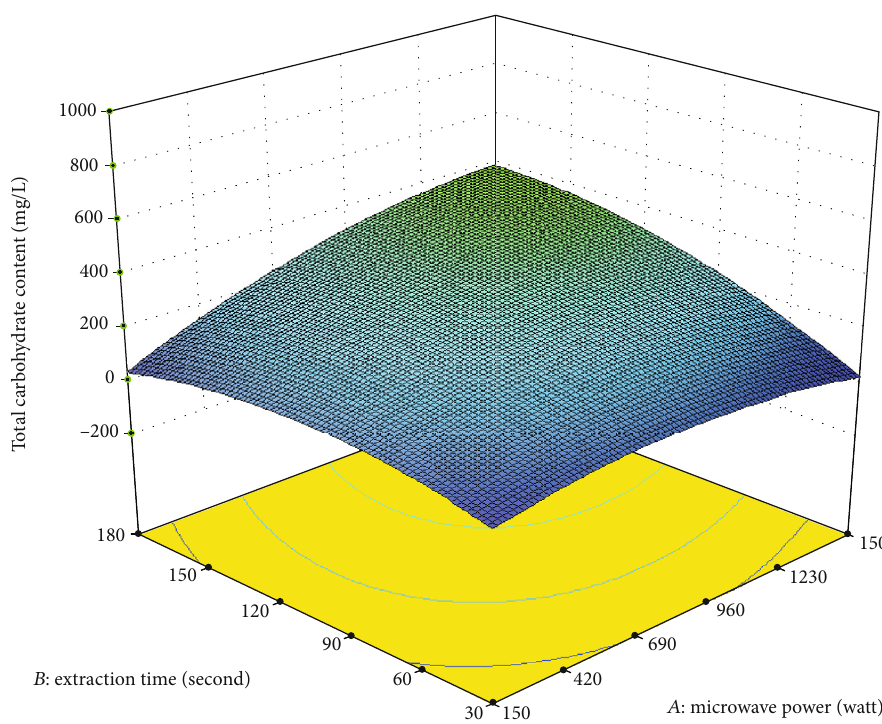
Figure 1: Response surface plot showing the e ff ect of microwave power and extraction time on the total carbohydrate